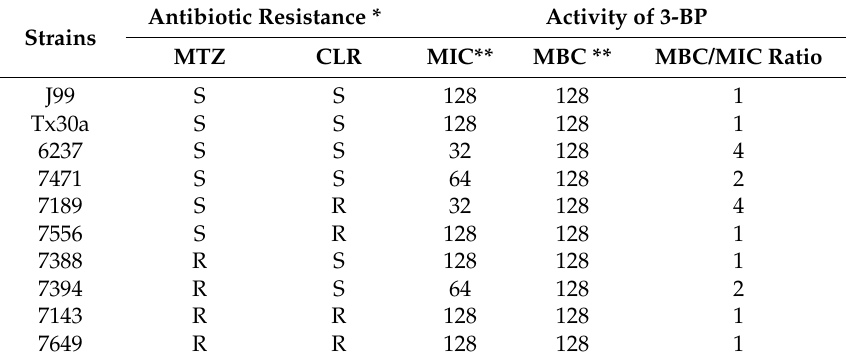
Table 2. The minimal inhibitory concentrations (MICs) and minimal bactericidal concentrations (MBCs) of 3-Bromopyruvate (3-BP) against selected H. pylori strains. Antibiotic Resistance * Activity of 3-BP Strains MTZ CLR MIC** MBC ** MBC/MIC Ratio J99 S S 128 128 Tx30a S